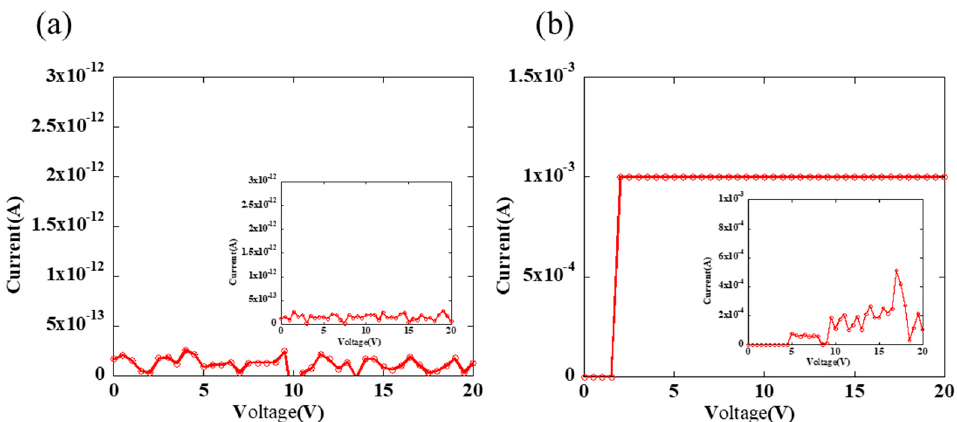
Figure 6. The current as a function of voltage when the probes stabbed at the opposite angles of a single ring: ( a ) annealing at 200 ◦ C for 30 min, and ( b ) annealing at 400 ◦ C for 30 min. The drop space is 150 µ m. Insets are the shorting tests results between two silver traces.